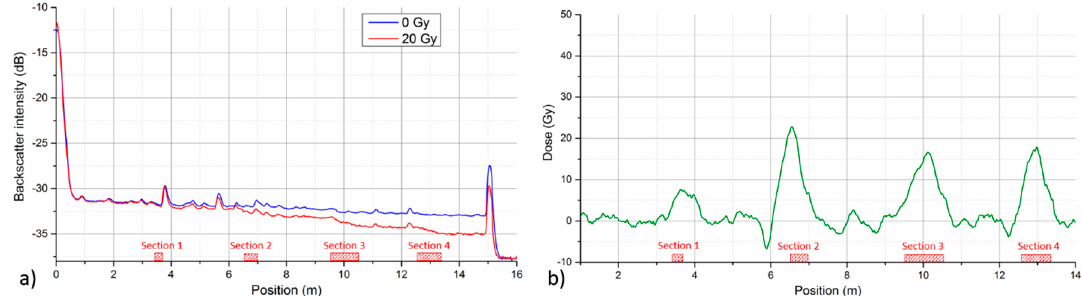
Figure 7. ( a ) Fiber backscattering traces before and after irradiation to 20 Gy. ( b ) Reconstructed dose distribution along the irradiated fiber. Four irradiated sections are indicated by red striped bars on the X-axis.